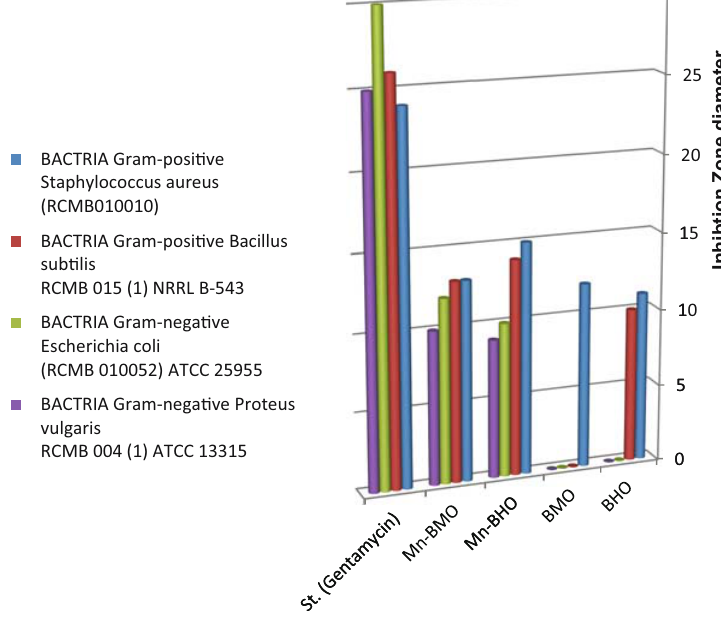
Figure 7: Antibacterial activity for ligands and their manganese ( II ) complexes.